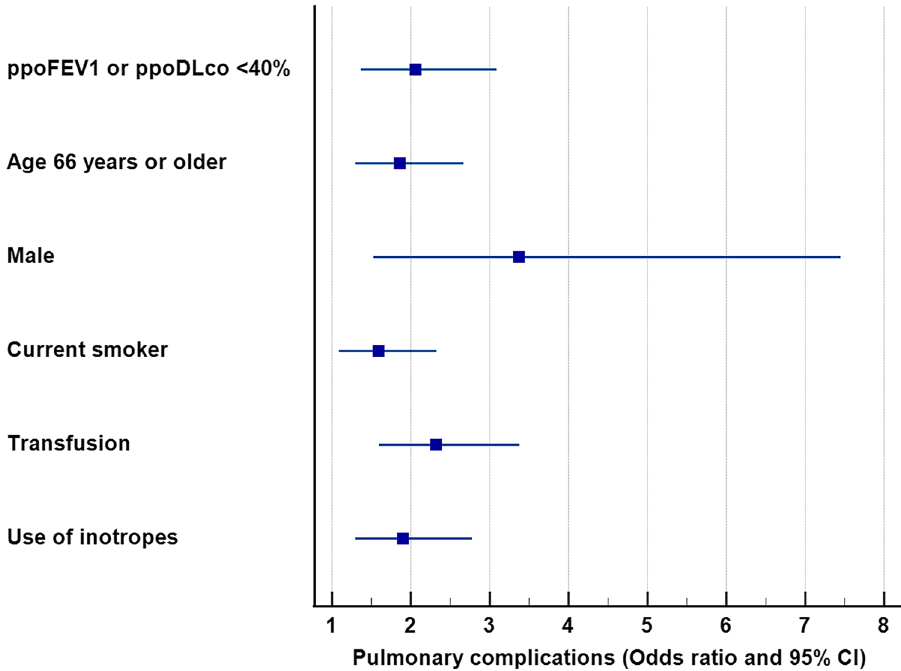
Figure 3. Independent association between risk factors and postoperative pulmonary complications. ppoFEV 1 predicted postoperative expiratory volume in 1 s, ppoDL CO diffusing capacity for carbon